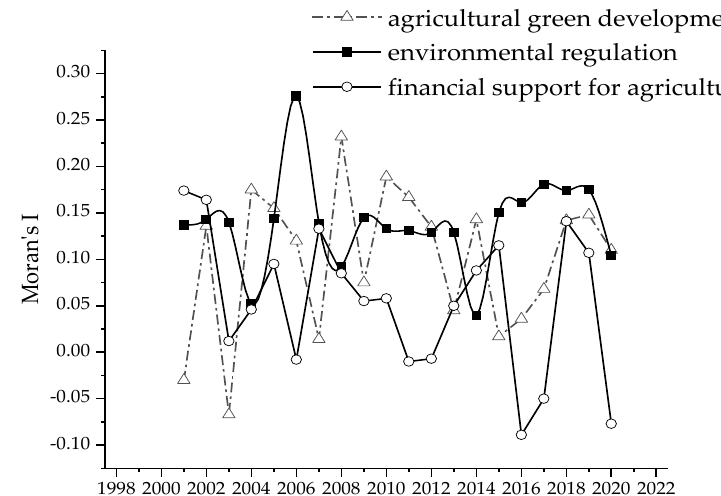
Figure 1. Moran’s I index test results.